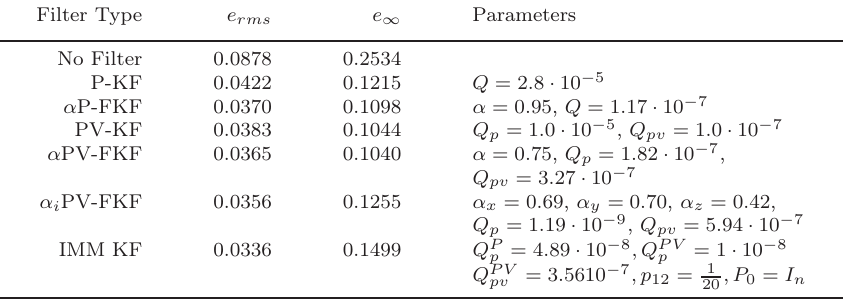
Table 1. Performance of different Kalman Filters for the HEAD data set.